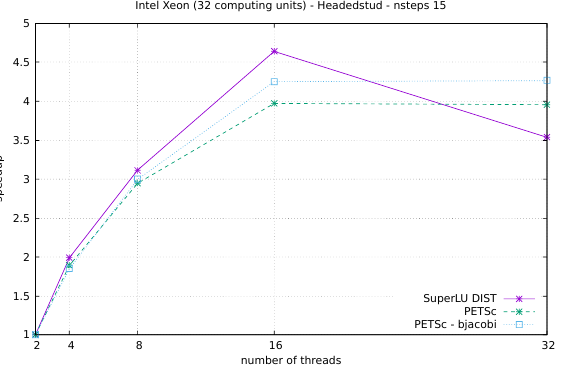
Figure 9. Speedups using the Newton-Raphson method with secant stiffness updated every